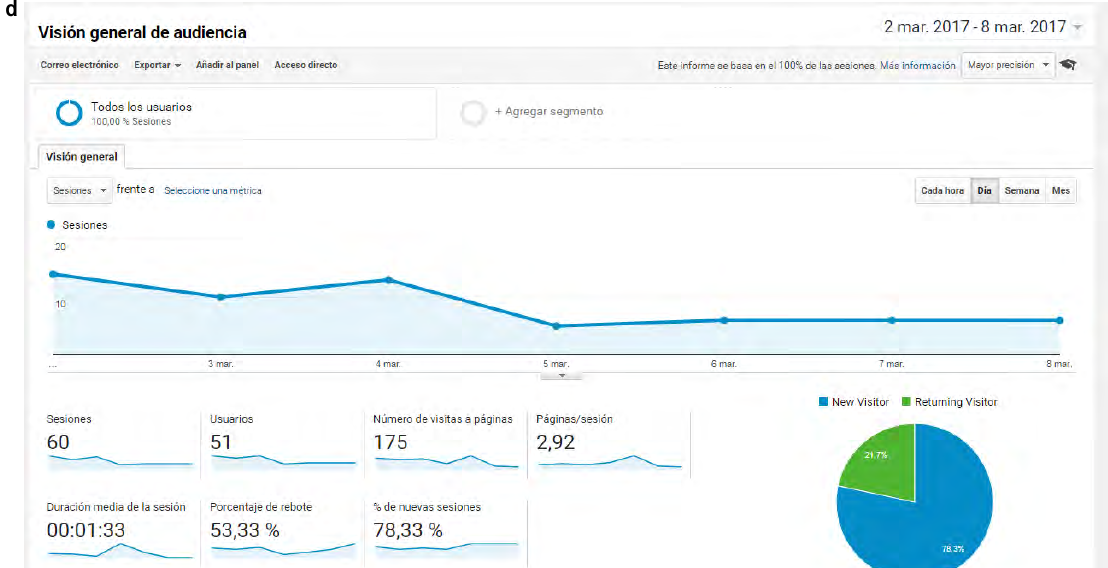
Figure 3 The visits of Tungurahua Turístico Statistic